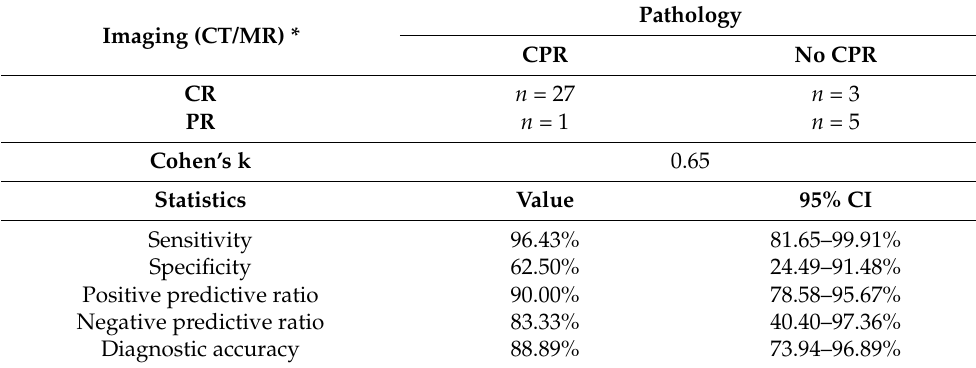
Table 2. Rad-path